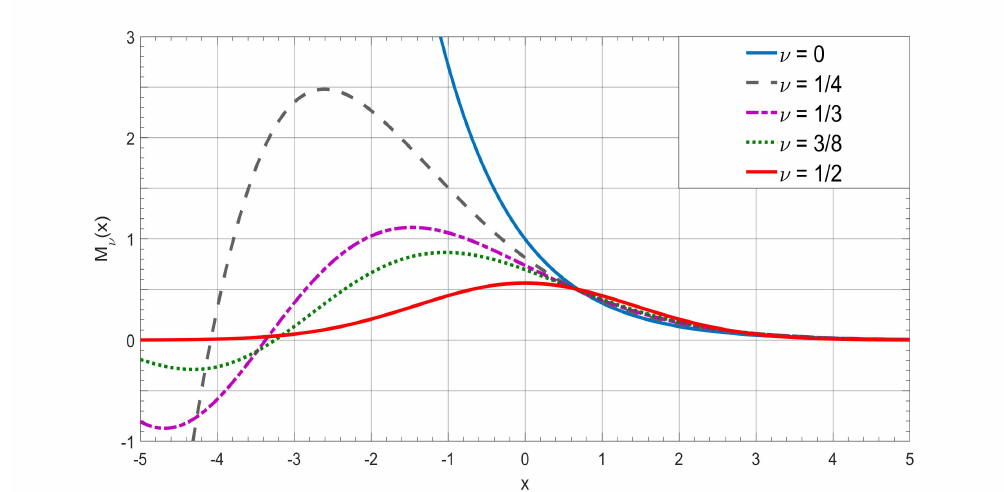
Figure 1. Plots of the M -Wright function as a function of the x variable, for 0 ≤ ν ≤ 1/2.